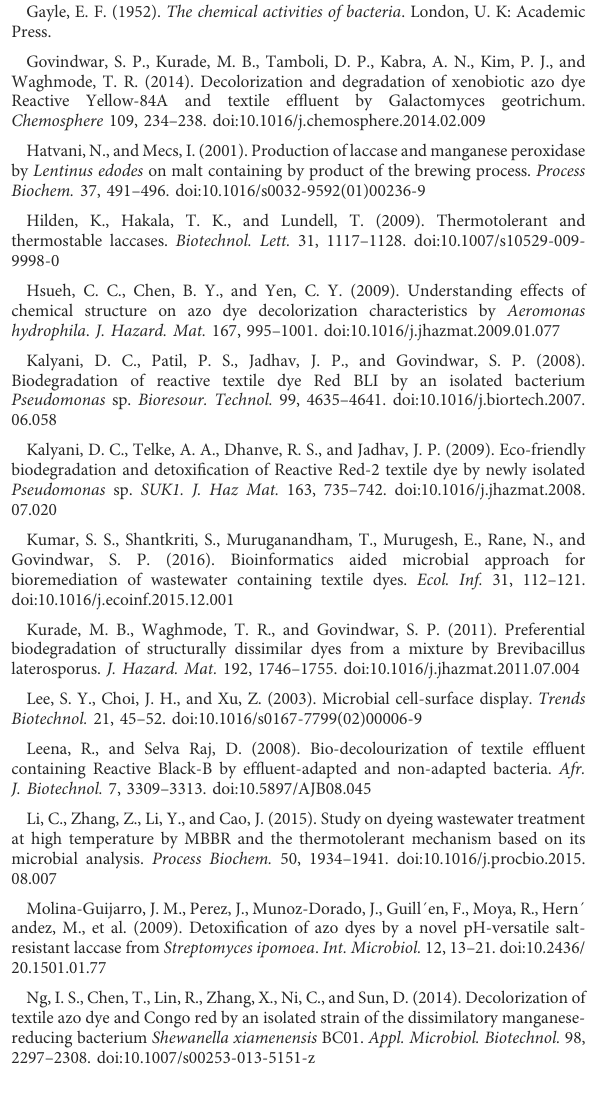
SUPPLEMENTARY FIGURE S1 Analysis of decolorization of chosen textile dyes by Lysinibacillus sphaericus MTCC 9523 at various time